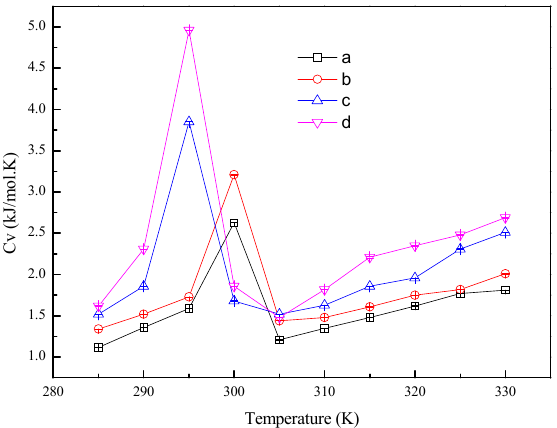
Figure 8. Heat capacity of the n -octadecane/Cu nanoparticle nanofluids with different temperatures. ( a ) 128 n -octadecane molecules; ( b ) 1 Cu nanoparticle and 512 n -octadecane molecules; ( c ) 1 Cu nanoparticle and 256 n -octadecane molecules; ( d ) 1 Cu nanoparticle and 128 n -octadecane molecules.